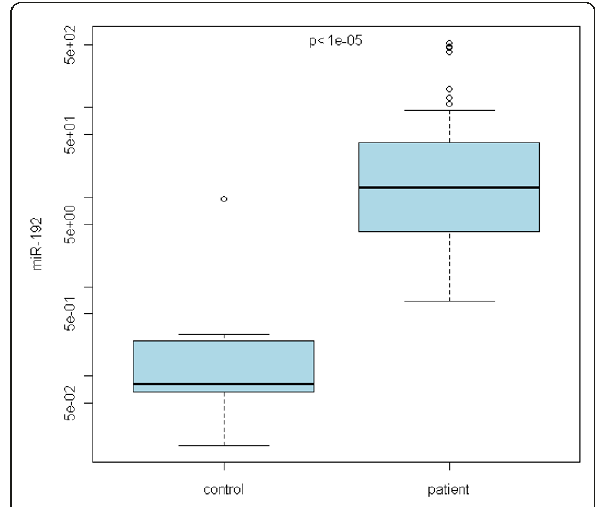
Figure 2 miRNA-192 statistically significant upregulation in BE patients .